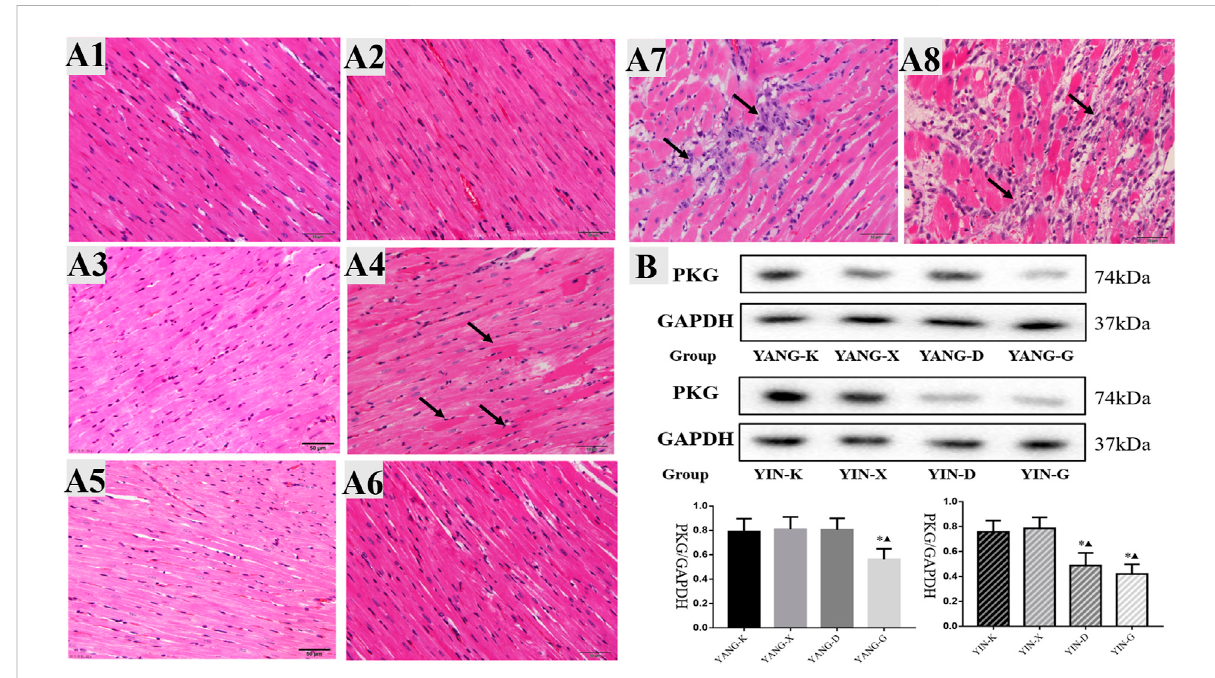
FIGURE 6 Cardiac histology and protein expression of PKG for rats in different groups. Note: (A) cardiac histology and (B) protein expression of PKG in heart issue: 1)YANG-Kgroup, 2)YANG-Xgroup, 3) YANG-D group, 4) YANG-Ggroup, 5) YIN-K group, 6) YIN-X group, 7) YIN-D group, and 8) YIN-G